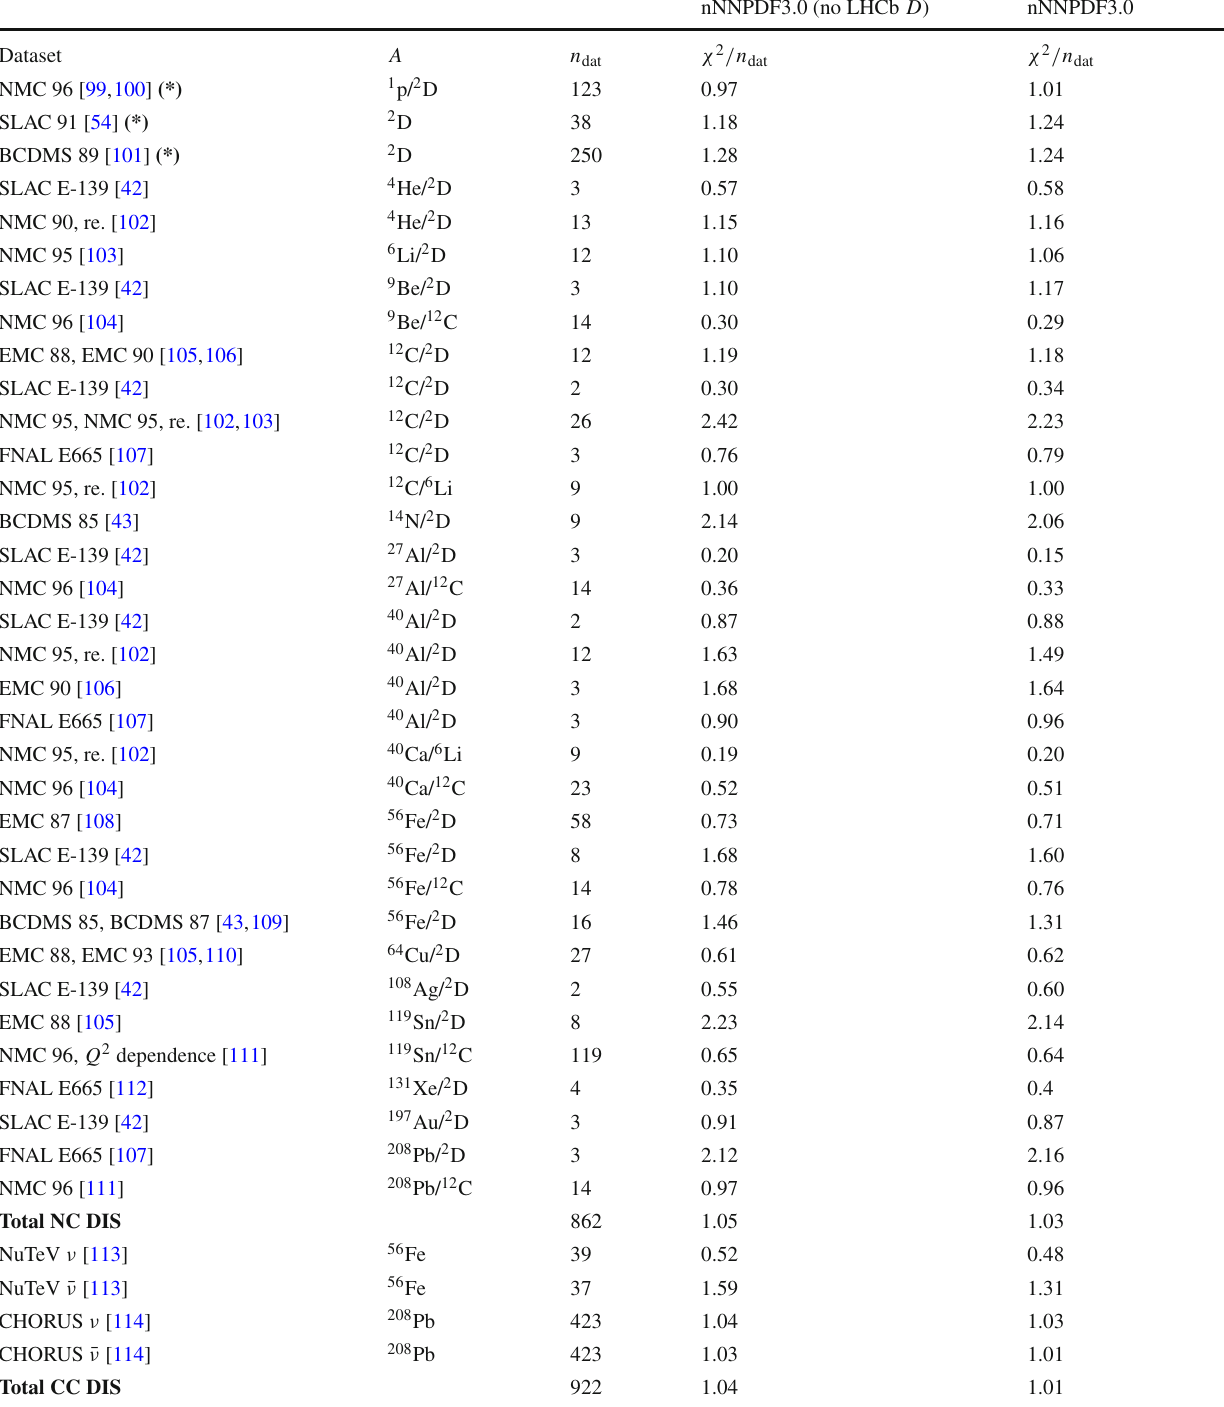
the LHCb D -meson cross-sections) and with nNNPDF3.0. Datasets labelled with (*) are new in nNNPDF3.0 as compared to its predeces- sor nNNPDF2.0. The datasets are separated into neutral-current (upper) and charged-current (bottom part) structure